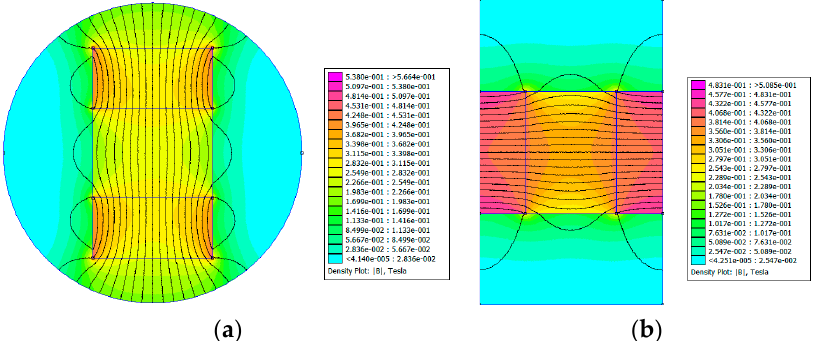
Figure 4. Distribution of the magnetic field for test samples with MRF unit. ( a ) Type A − 20; ( b ) Type B − 15.